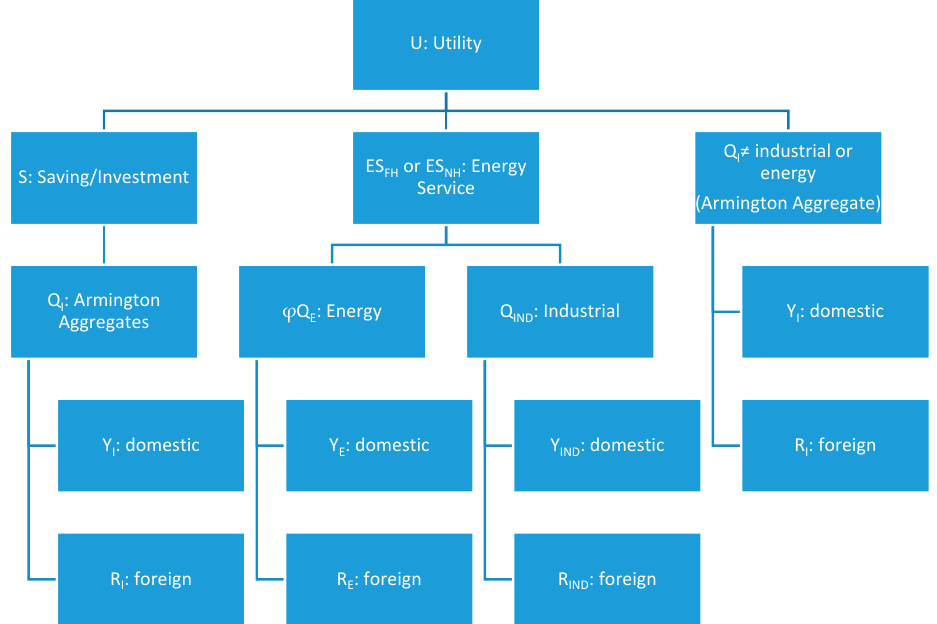
Figure 1. Model structure of utility generation through household consumption.